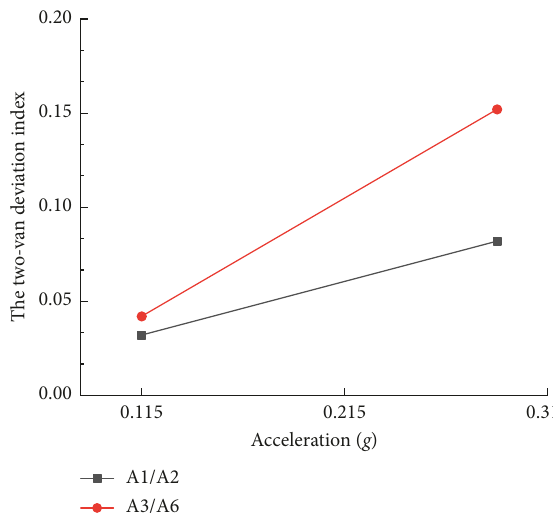
Figure 10: Soil-rock combination stratum two-van deviation curve.